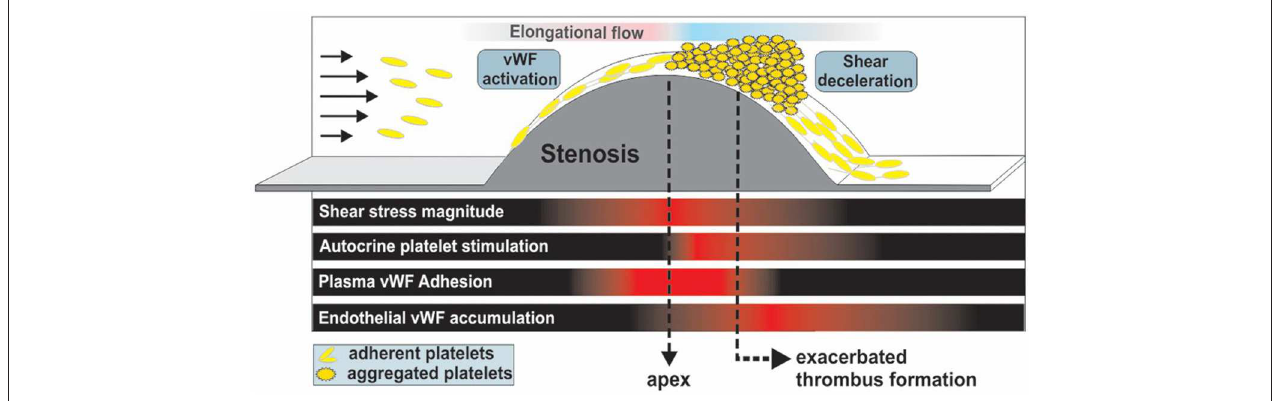
FIGURE 4 | Thrombus formation and propagation is aggravated post-stenosis (simulating atherosclerotic-like geometries) in a VWF-dependent fashion due to shear deceleration, autocrine platelet stimulation and elevated VWF deposition at the stenosis outlet. Adapted with permission from Westein et al.